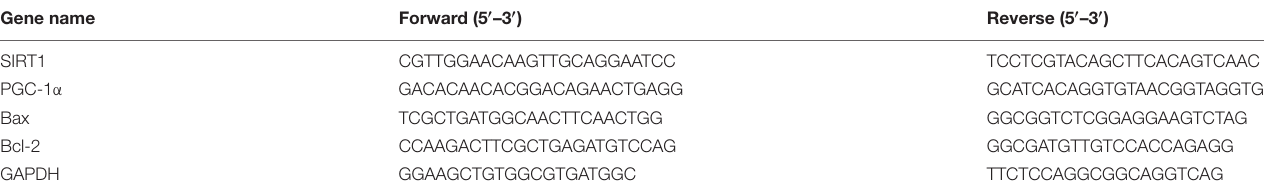
TABLE 2 | Sequences of primers used in this